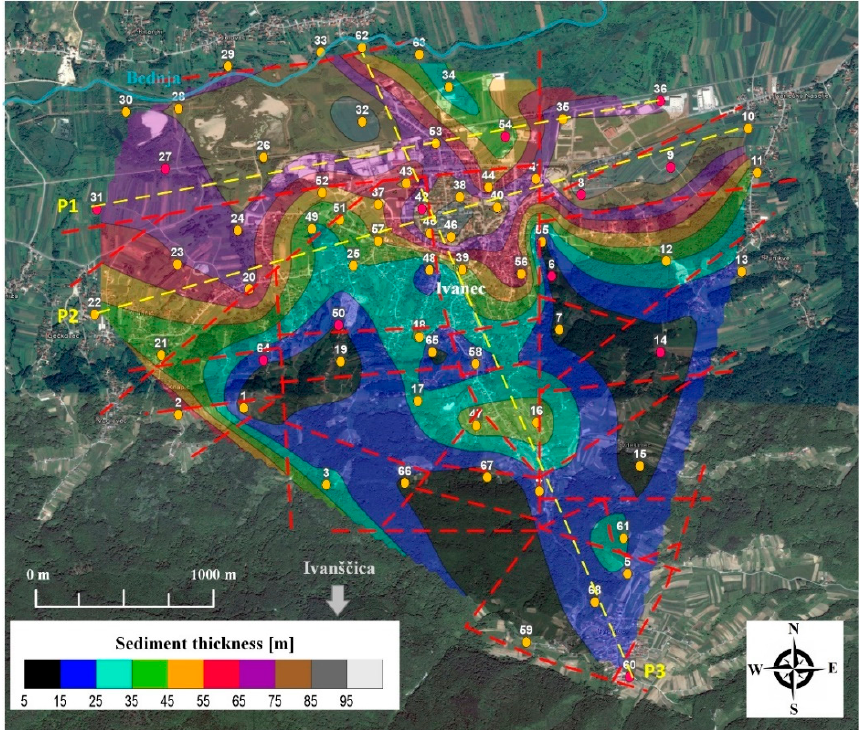
Figure 9. Map of sediment thickness cover above bedrock for the City of Ivanec with marked faults (red dashed lines) from geological map (Figure 3). Red circles indicate location of geophysical measurements and yellow microtremor measurements.